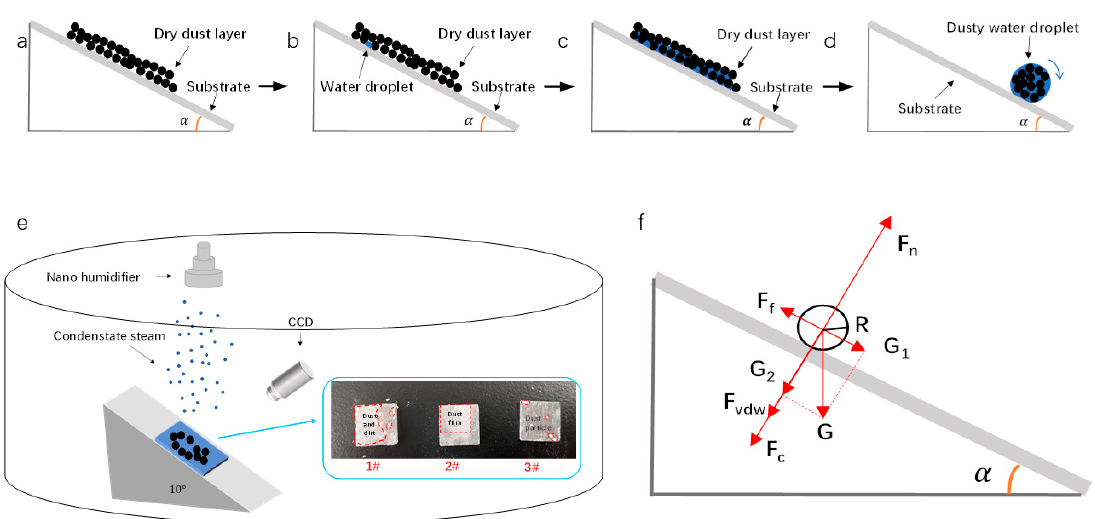
Figure 4. Schematic diagram of the dust removal experimental system. ( a – d ) Schematic diagram of the self-cleaning process; ( e ) schematic diagram of the dust removal experiment; ( f ) force analysis diagram of dust-containing droplet particles.